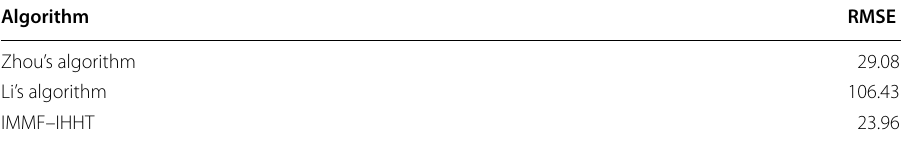
Table 6 RMSE of three